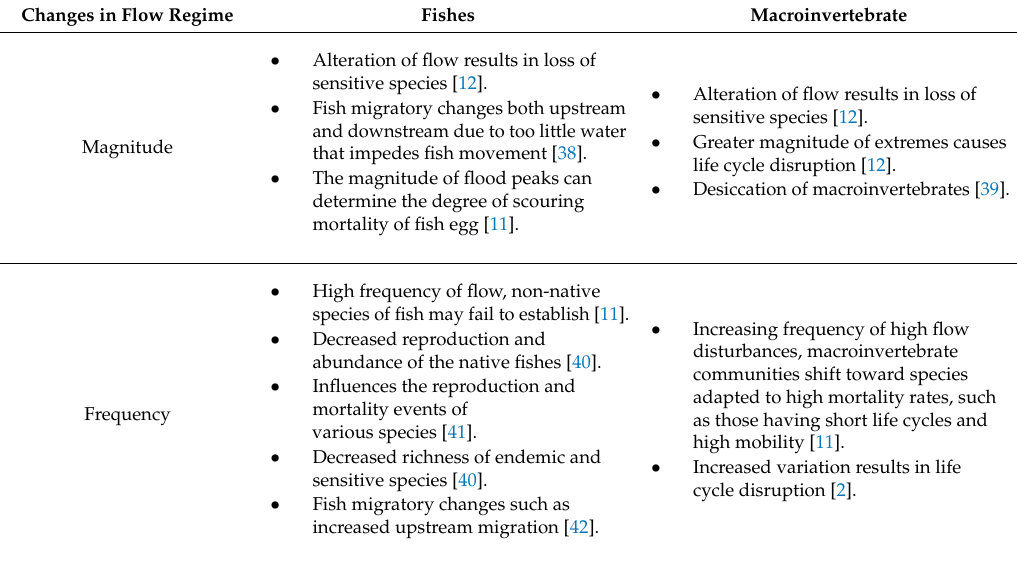
in relation to the changes in the elements of streamflow